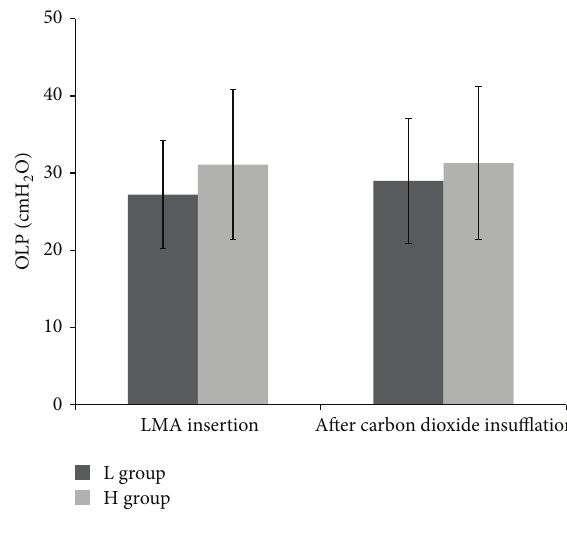
Figure 2: Changes of oropharyngeal leak pressure (OLP) before and after pneumoperitoneum with carbon dioxide (CO 2 ) insufflation. LMA: laryngeal mask airway; L group: laryngeal mask airway (LMA) cuff pressure limiting 25cmH 2 O group; H group: LMA cuff pressure at 60 cmH 2 O